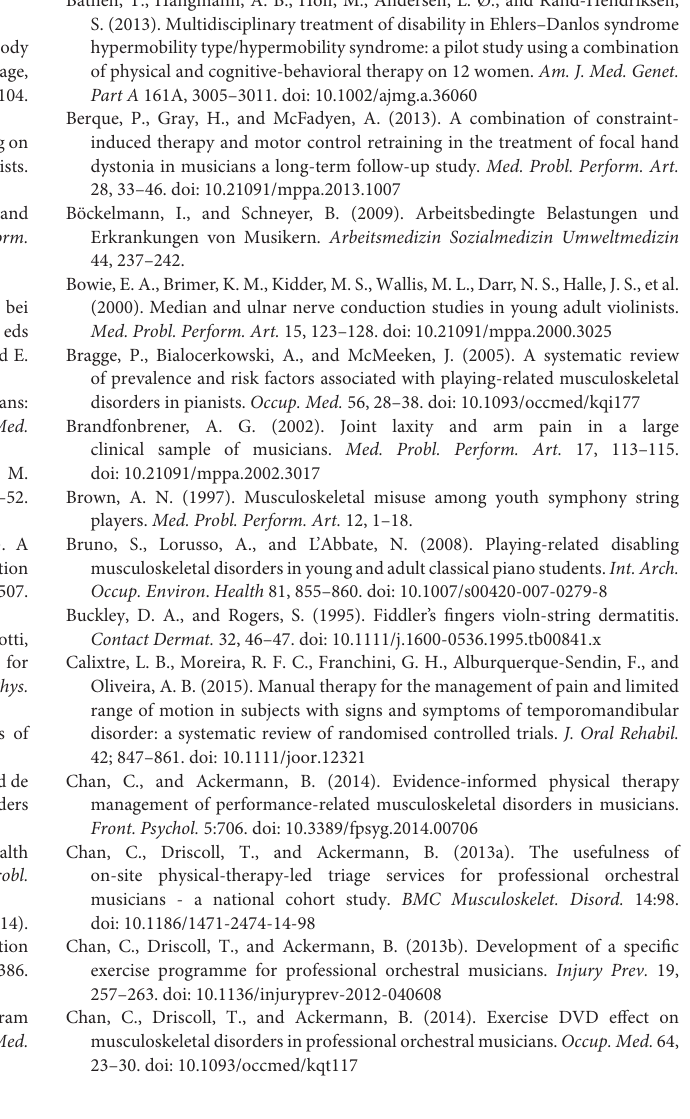
Table 1 and Winne Voget-Wiesen (professional pianist and singer) for his advice in interpreting the data based on his musical